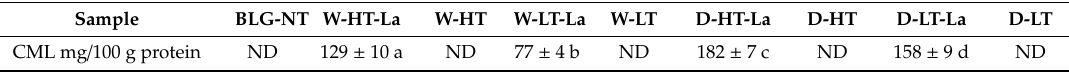
Table 3. CML quantities determined by uHPLC-ESI-MS / MS in the soluble fraction of BLG heated in the presence of lactose (La) using wet (W) or dry (D) heat treatment at either low or high temperature